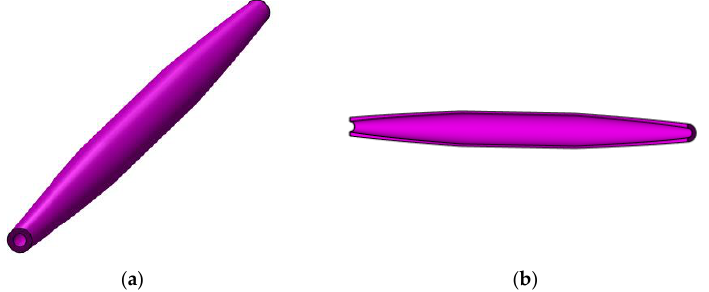
Figure 12. Geometrical model for a bar with trapezoidal variation in the second moment of inertia along the bar axis: ( a ) isometric view and ( b ) longitudinal section.